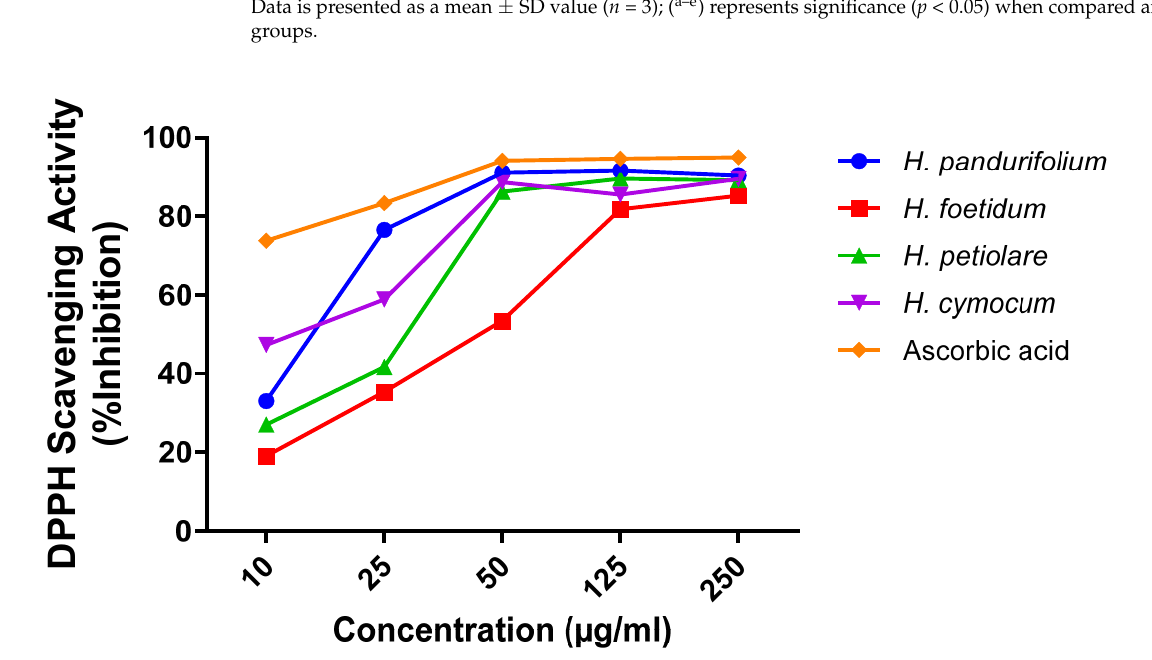
Figure 1. Percentage (%) inhibition of aqueous acetone extract of H. pandurifolium, H. foetidum H. petiolare, and H. cymocum . Table 2. Nitric oxide scavenging activity of H. pandurifolium, H. foetidum H. petiolare, and H. cymocum aqueous acetone